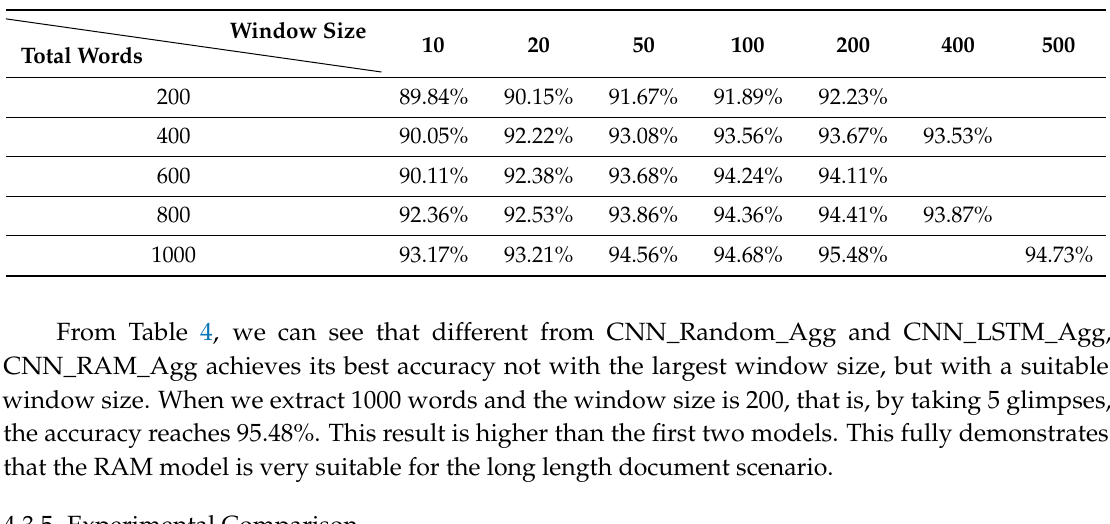
Table 4. Model CNN_RAM_Agg experimental